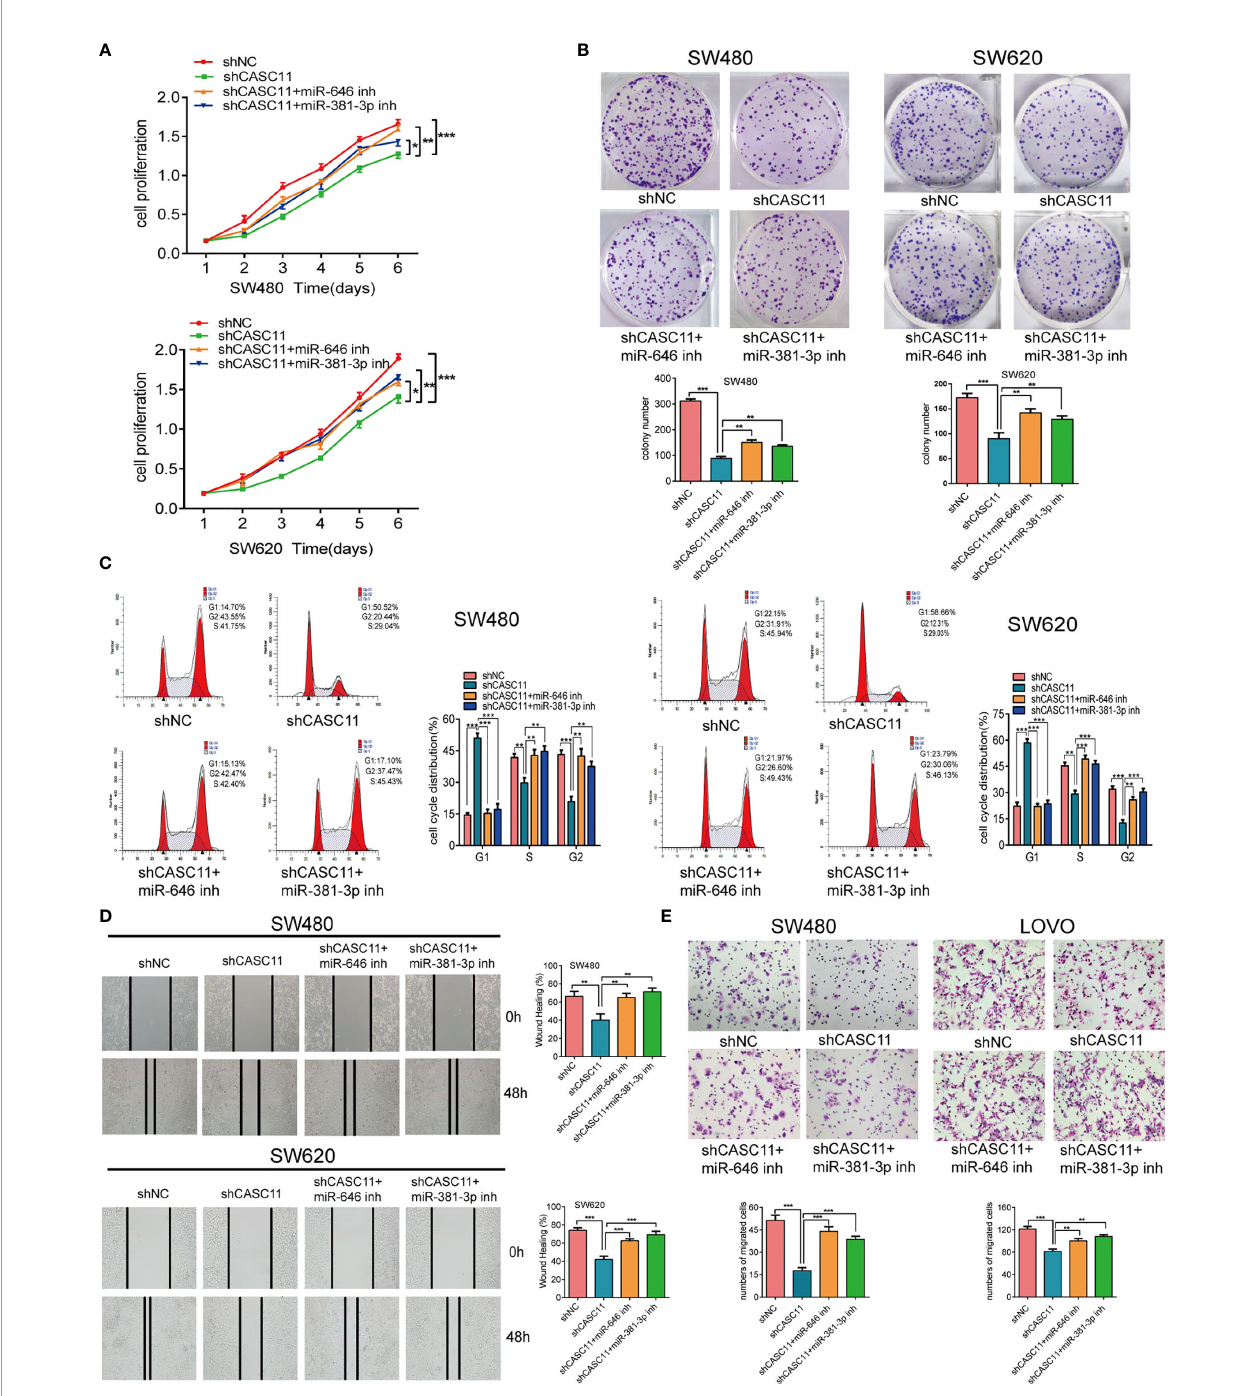
FIGURE 2 | miR-646 and miR-381-3p inhibitors reverse CASC11 interference -mediated phenotypes of CRC cell proliferation and migration in vitro . (A – C) Cell proliferation was assessed by CCK-8 assay, colony formation assay, and fl ow cytometry cell cycle analysis in CASC11-knockdown SW480 and SW620 cells. Error bars represent the means ± SD of 3 independent experiments. (D) Cell migration was analysed by scratch wound assay in CASC11-knockdown cells. The bar chart represents the percentage of distance at 48 h divided by the distance at 0 h. Error bars represent the means ± SD of 3 independent experiments. (E) Transwell migration assay used to evaluate the migration ability of cells with downregulated CASC11. Error bars represent the means ± SD of 5 different fi elds. * p < 0.05; ** p < 0.01; *** p <